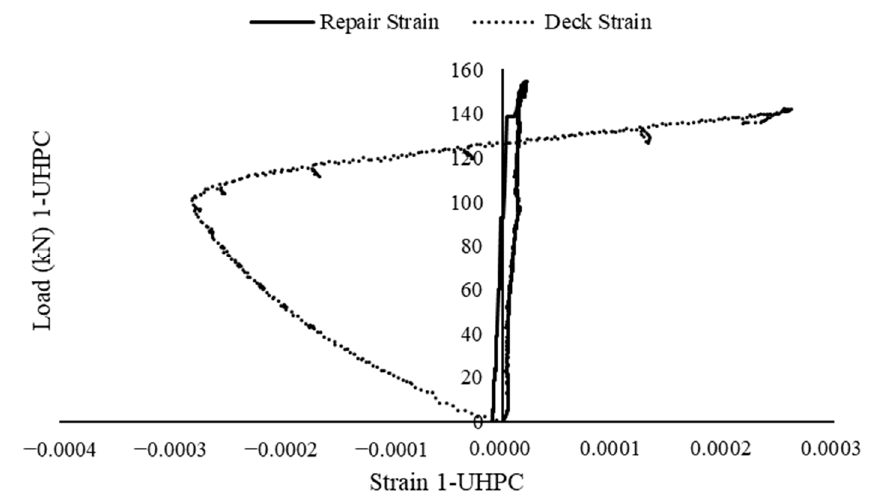
Figure 8. 1-UHPC load vs. strain for each instrumented reinforcing bar.